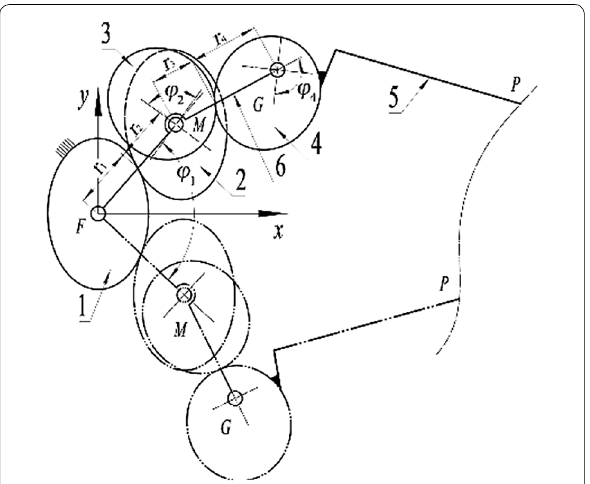
Figure 10 Schematic of the two-stage, four-gear transmission mechanism: 1. Sun gear, 2. First middle gear, 3. Second middle gear, 4. Planet gear, 5. Seedling arm, and 6. Planet